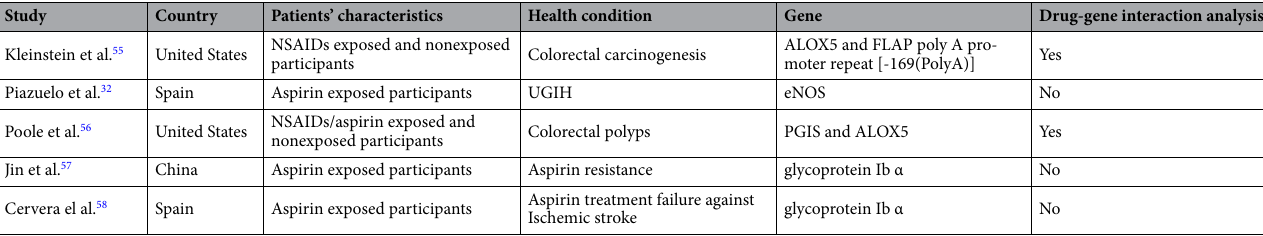
Table 4. Summary of studies characteristics about the interaction between VNTRs and aspirin or